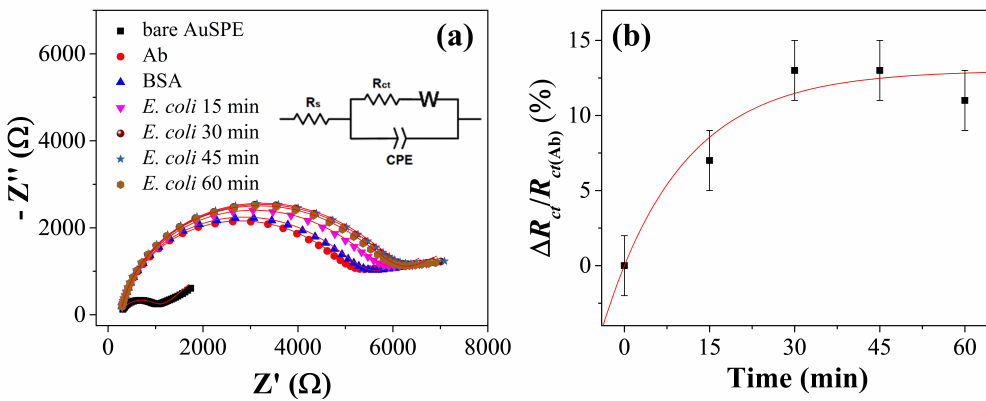
Figure 4. ( a ) EIS spectrum measured at di ff erent times with E. coli at 10 5 CFU mL − 1 ; ( b ) R ct as a function of time showing an exponential kinetic with a constant time of 14 ± 7 min.